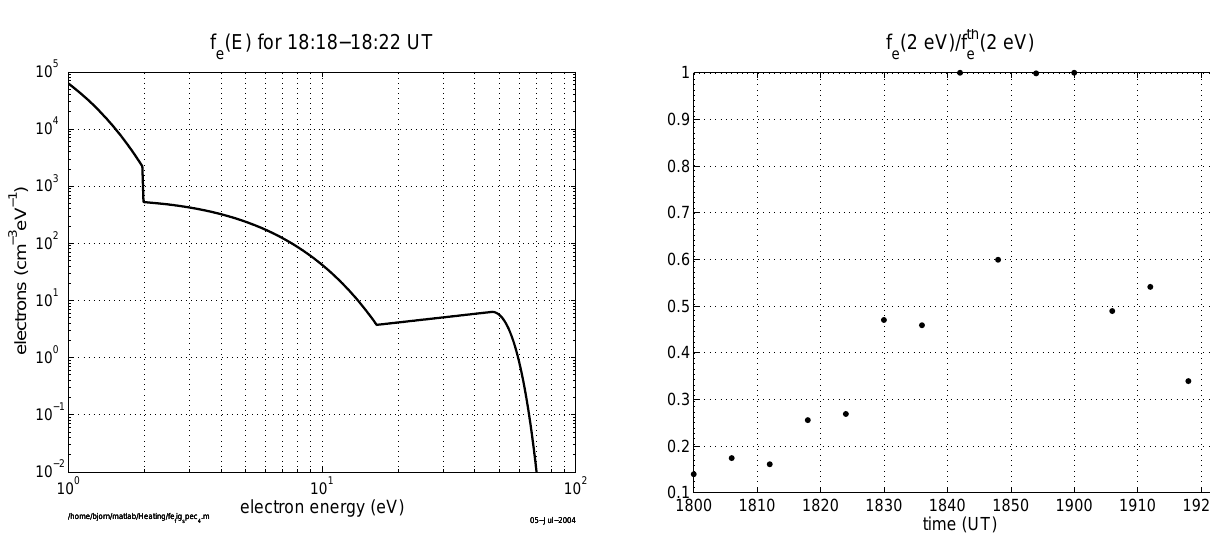
Fig. 8. Estimate of the ratio of f e (E)/f th e (E) at 2eV. Here f th e (E) denotes a thermal energy distribution. Note that the depletion is significant for the first five pulses when the approximate altitude of upper hybrid resonance is below 250km and varies for the last pulses when the interaction altitude is above 250km. This is con- sistent with the decrease in neutral concentrations with increasing altitudes.